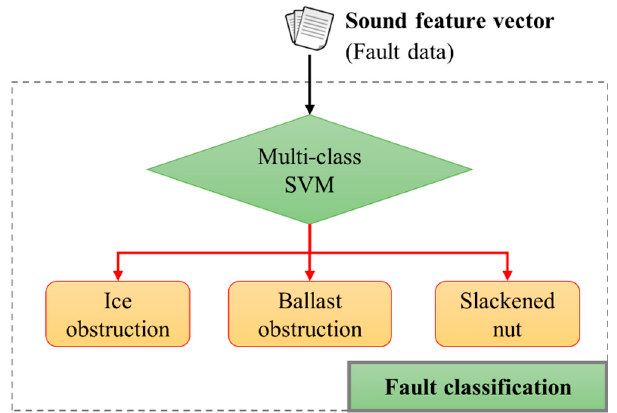
Figure 12. Architecture for fault-sound classification based on a multi-class SVM.